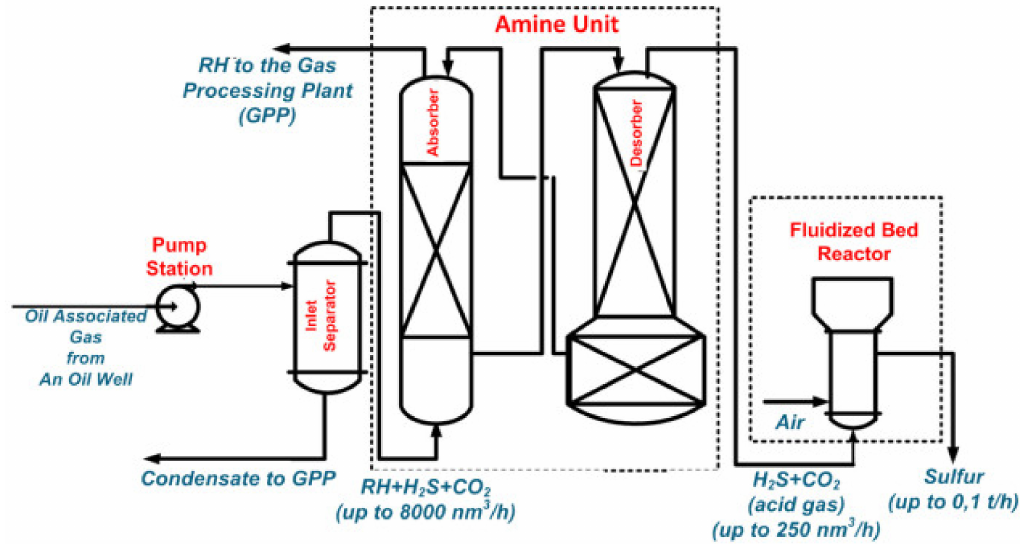
Figure 21. Bavly gas shop of PJSC Tatneft. Purification of associated oil gas. Amine treatment and direct oxidation.